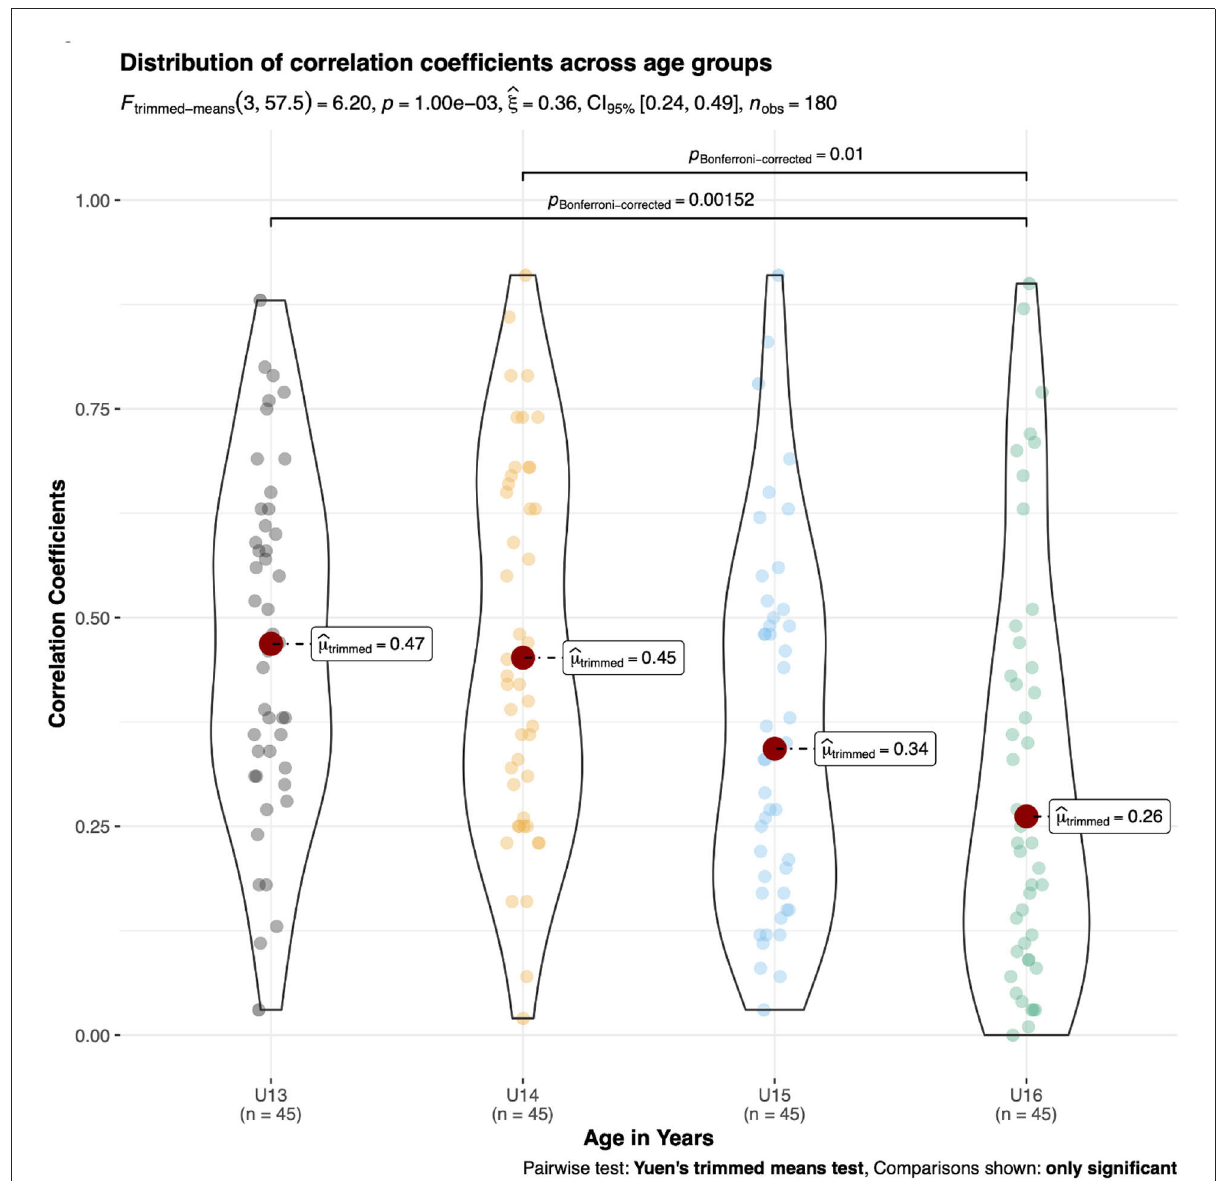
FIGURE5 Post-hoc tests on trimmed means of different age categories of absolute inter-item correlation coefficients in young male